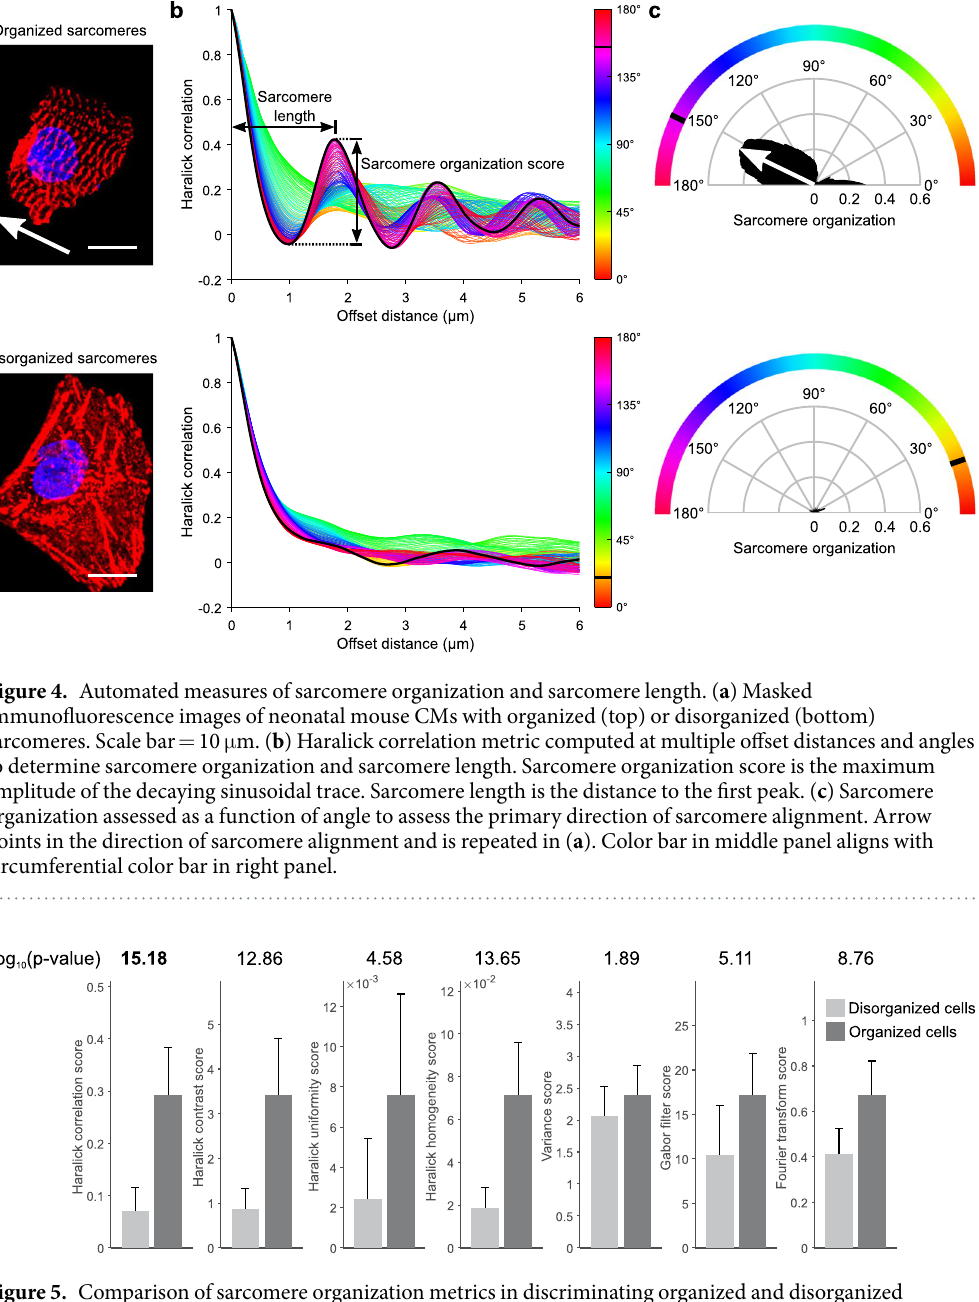
These methods introduce a new framework for using multiple immunofluorescence channels to auto- matically segment cells and analyze both morphological and cytoskeletal features of neonatal mouse and fibroblast-reprogrammed cardiomyocytes. The segmentation algorithm can be used without prior manual cell type classification, as it was with the reprogrammed cardiomyocytes. This allows for the identification of cells